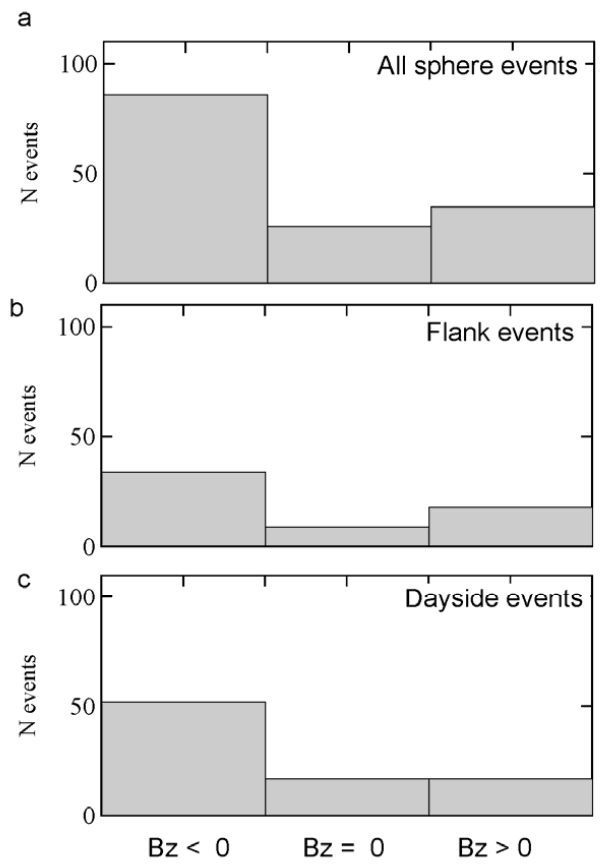
Fig. 9. Histograms of event occurrence as a function of IMF for (a) all magnetosphere events, (b) magnetosphere FTEs with | Y | > 10 R E , and (c) magnetosphere FTEs with | Y GSM 10 R E .